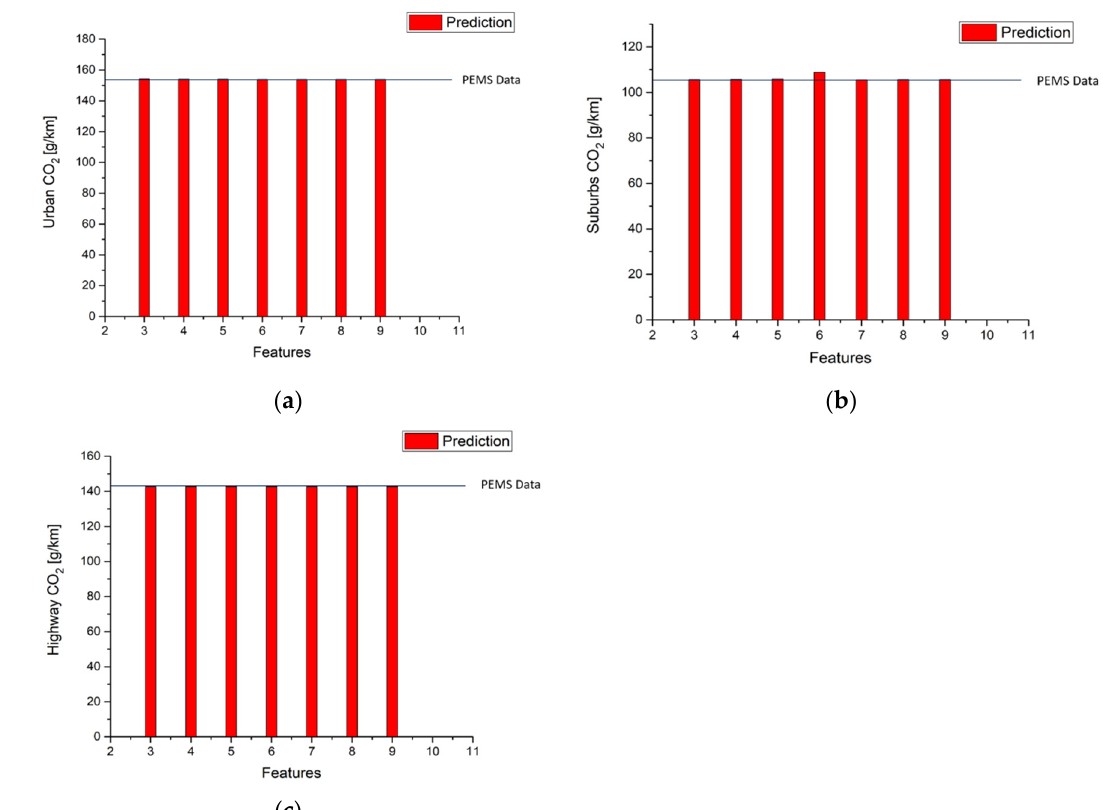
Figure 14. Results of CO 2 emission factor predictions ( a ) Urban; ( b ) Suburbs; ( c ) Highway.